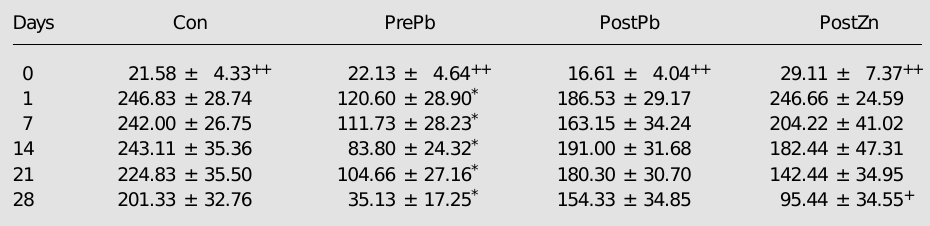
Table 1 - Latency to enter the dark chamber (mean ± SEM) for the control group (Con), prenatal lead group (PrePb), postnatal lead group (PostPb) and postnatal zinc group (PostZn). ++ P<0.01 compared to the subsequent sessions (repeated measures ANOVA); *P<0.05 compared to the respective control group (Tukey multiple comparison test after one-way ANOVA); + P<0.05 compared to the first testing day (Tukey multiple comparison test after repeated measures